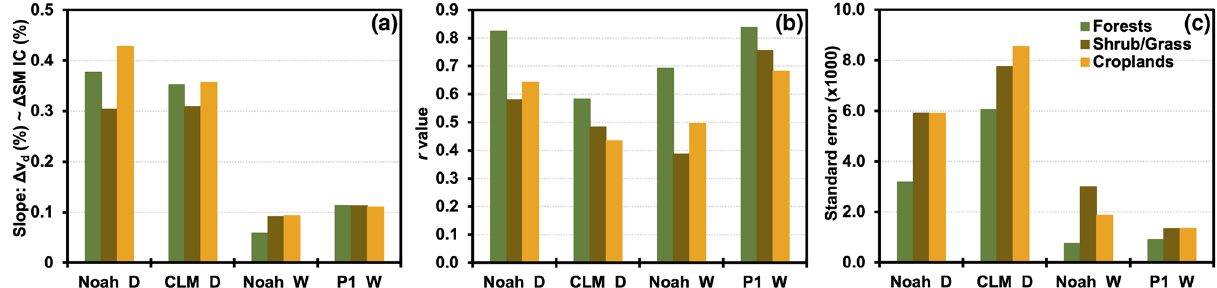
Figure 9. (a) Regression slopes of the relative changes of O 3 dry-deposition velocity v d versus the relative changes of column-averaged soil moisture initial conditions (SM ICs) due to the SMAP DA, summarized by three LULC groups for all model cases listed in Table 1. The r values of these regression analyses and the standard errors of slopes (%, scaled by 1000) are indicated in (b) and (c) , respectively. The p values for all regression analyses are (cid:28) 0 . 01. Regression results for the relative changes of O 3 deposition flux versus the relative changes of SM ICs are similar (not shown in